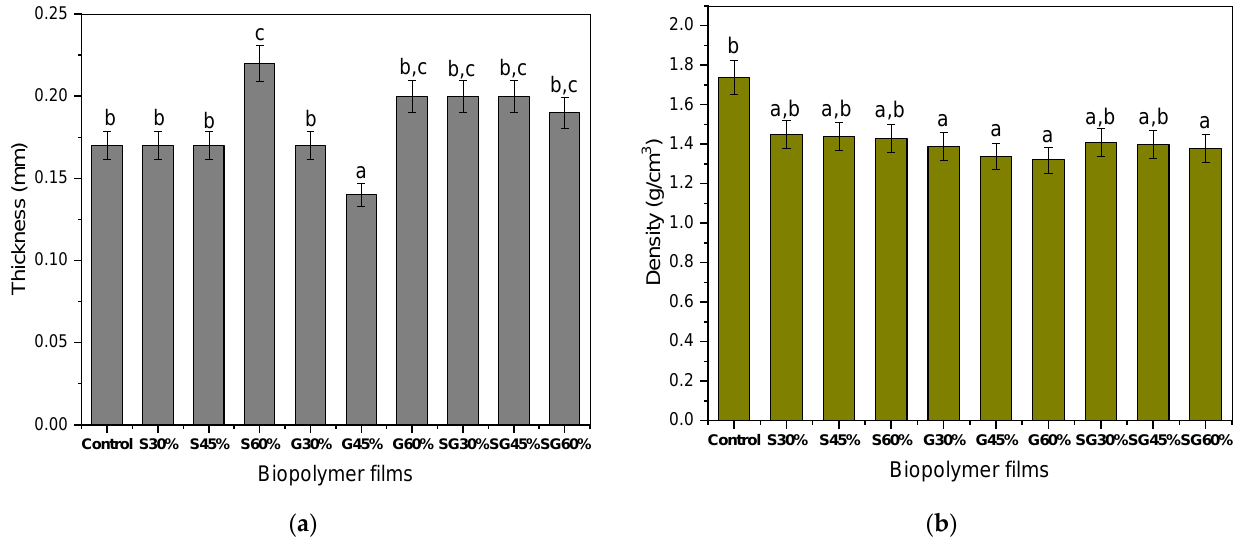
Figure 2. ( a ) Thickness and ( b ) density of cornstarch biopolymer films. a,b,c Values with different letters in the figures are significantly different ( p < 0.05).